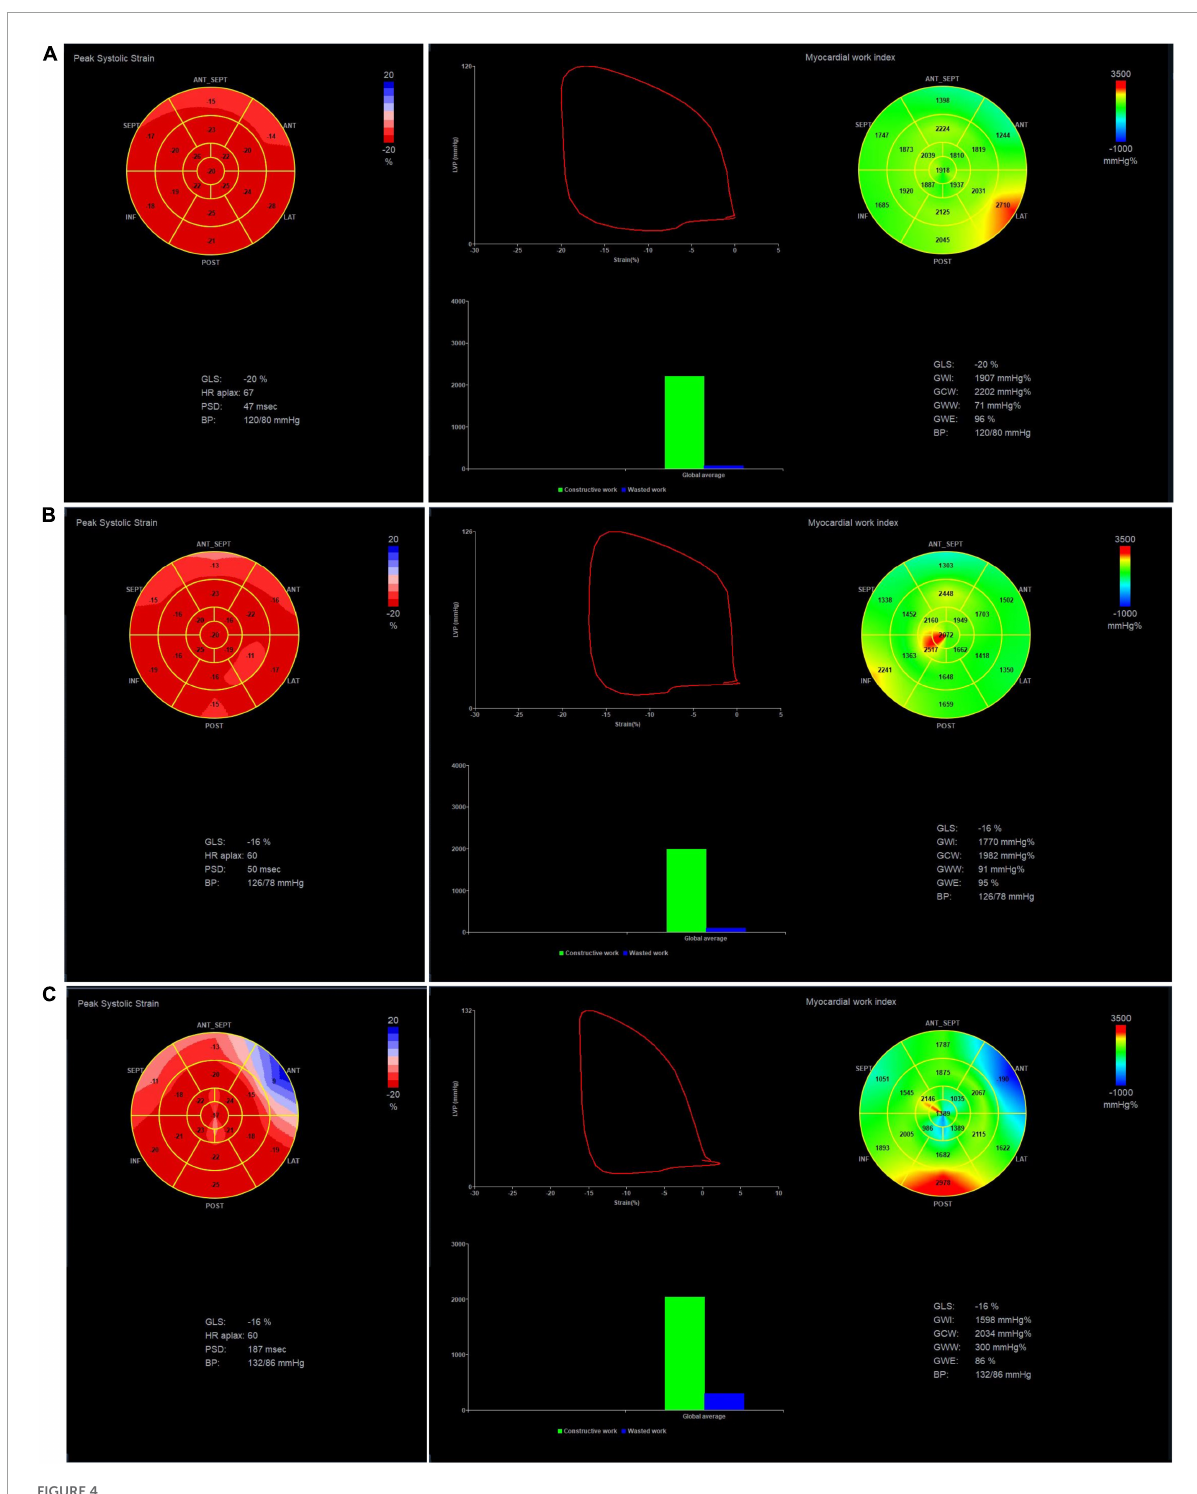
FIGURE4 GLS, GWI, GCW, GWW, and GWE of the three groups at 4D mode. (A) Normal group, (B) HPSAP group, and (C) VSP group. Comparing the three groups, the strain bull’s eye graph of the normal group is red, the VSP group is lighter, and even appears blue; the work index bull’s eye graph of the normal group has a uniform green distribution, and the GWI is higher. The work index bull’s eye graph of the VSP group indicated that the work index was unevenly distributed, and the GWI was the